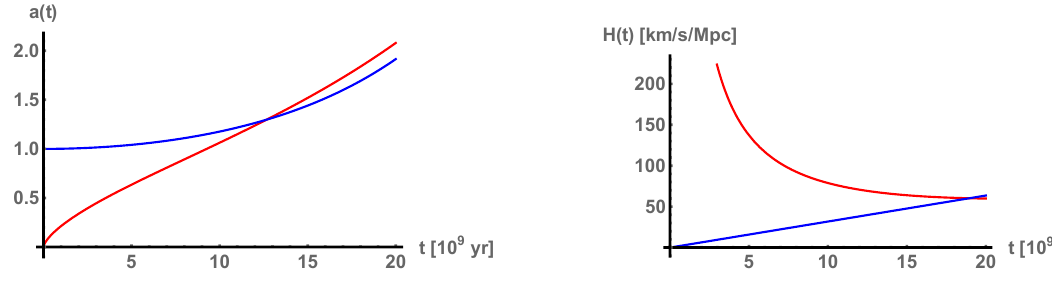
Figure 1 . Scale factors a 1 ( t ) = A t 2 3 e Λ1 14 t 2 , (red) and a 2 ( t ) = A e Λ 6 t 2 , (blue) are on the left side. The corresponding Hubble parameters H